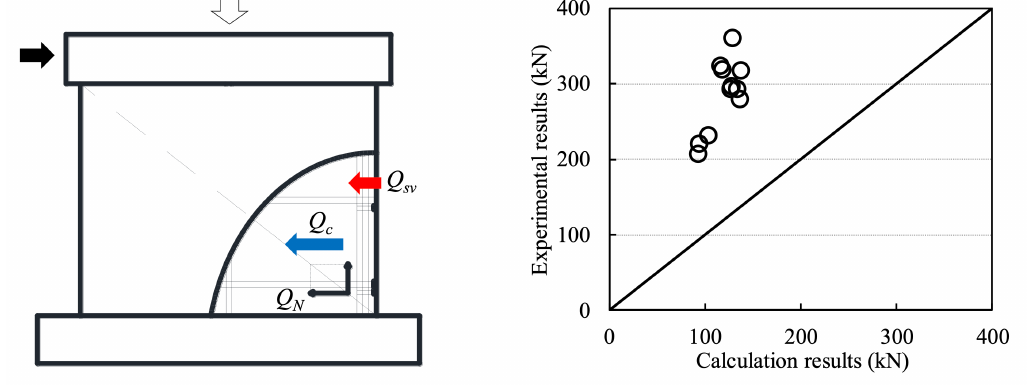
Figure 14. Concept and calculation results of sectional force